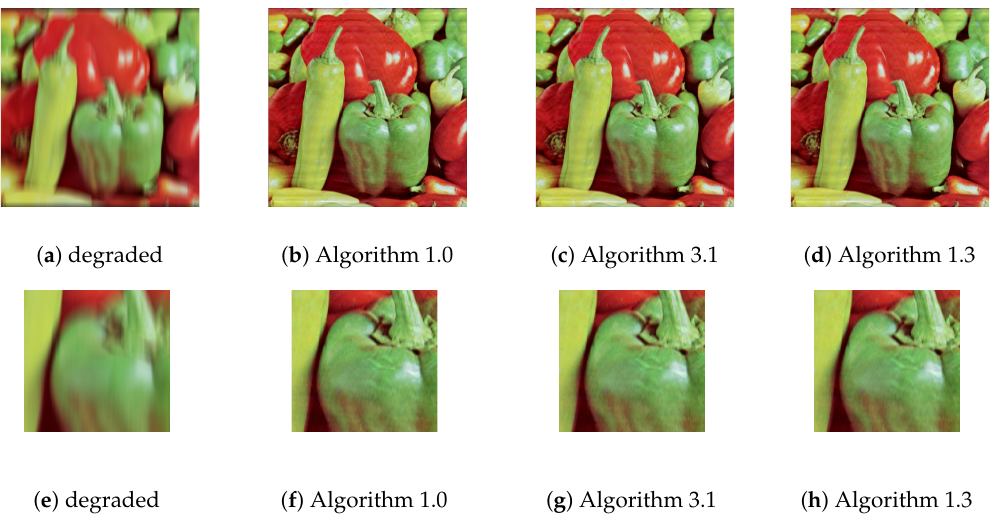
Figure 4. Degraded and restored ( a – d ) Pepper images and ( e – h ) enlarged Pepper images by the various